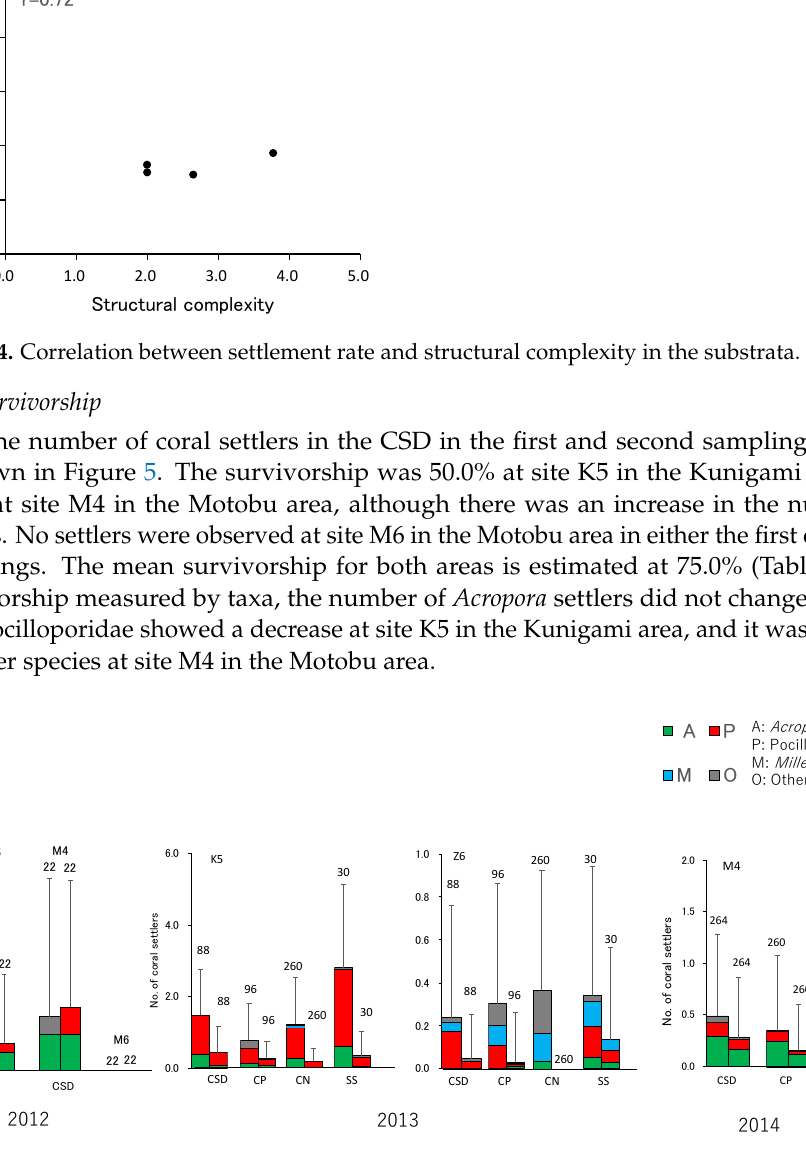
first and second samplings based on taxa. The data bar set comprises the first sampling on the left